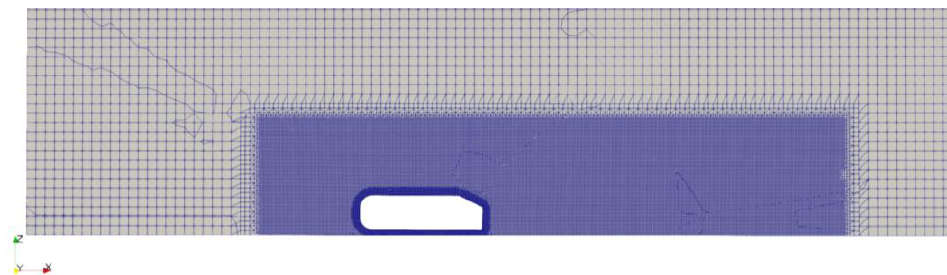
Figure 5. Refinement boxes over the Ahmed Body.